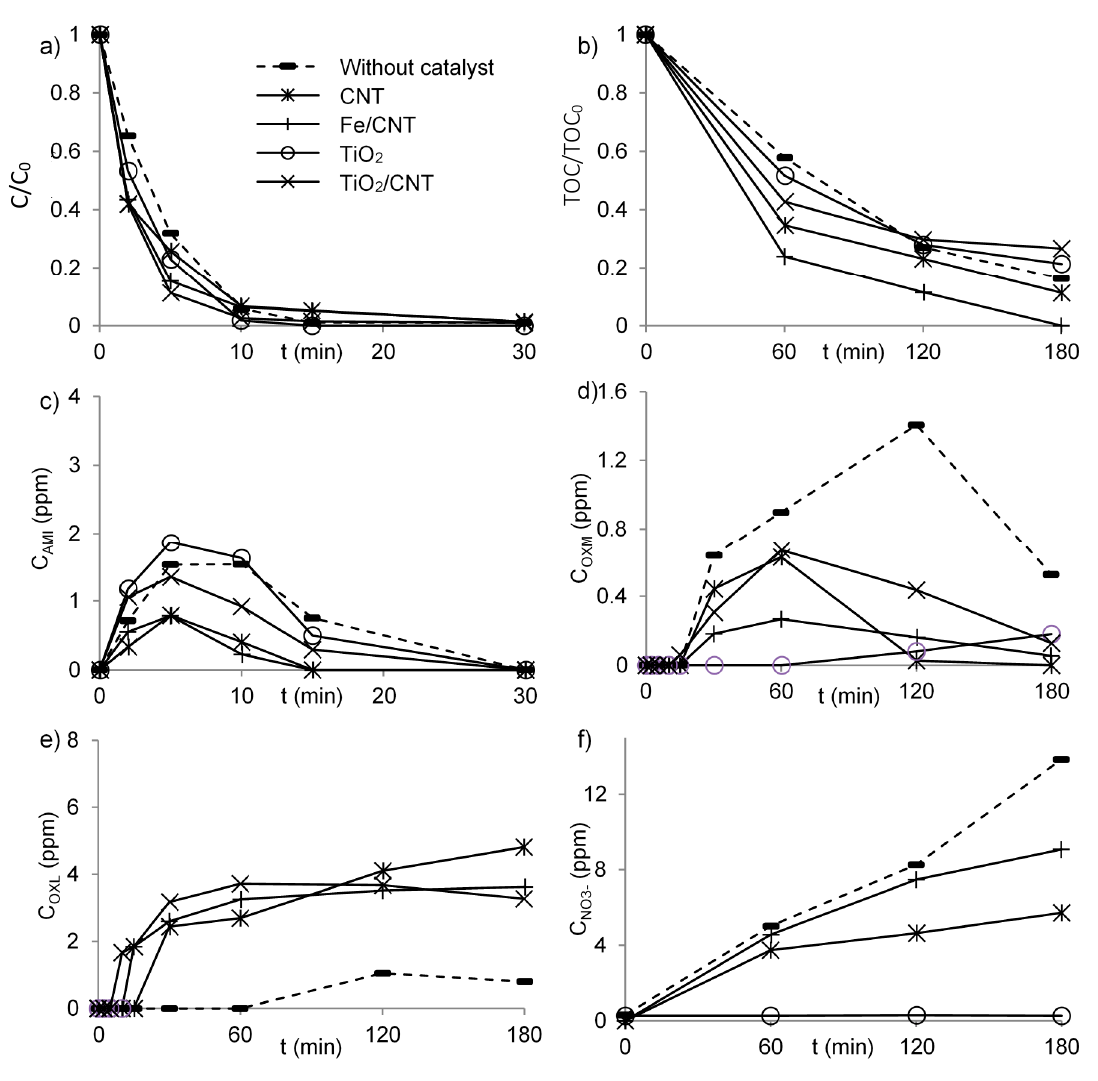
Figure 5. Dimensionless concentration of SMX ( a ) and TOC ( b ) and evolution of AMI ( c ), OXM ( d ), OXL ( e ), and NO 3 − ( f ) concentrations during photocatalytic ozonation with H 2 O 2 in the presence of CNT, Fe/CNT, TiO 2 , and TiO 2 /CNT.